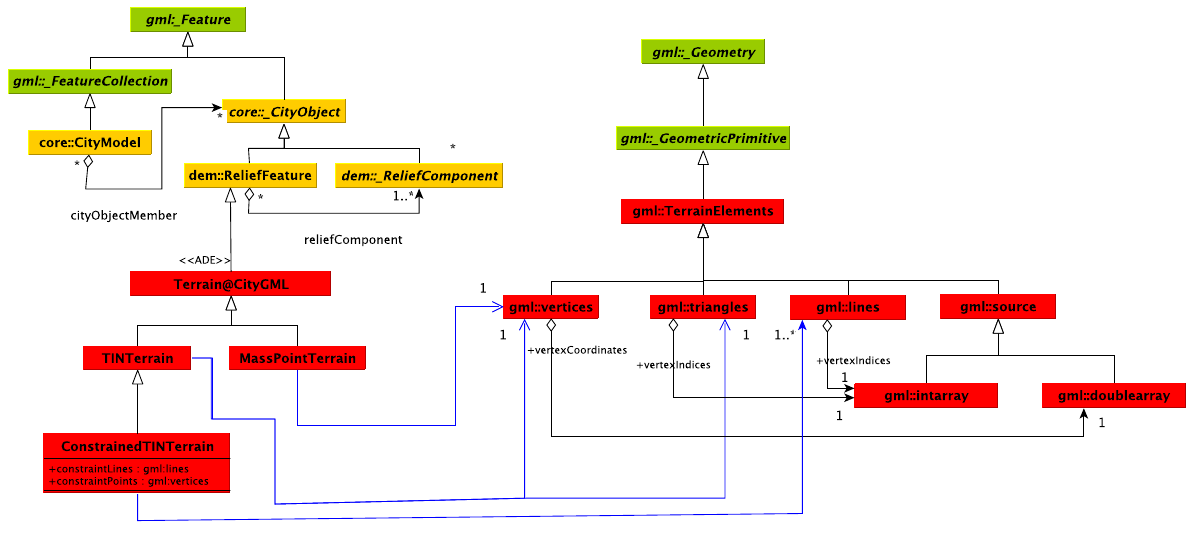
Figure 8: Proposed basic UML of